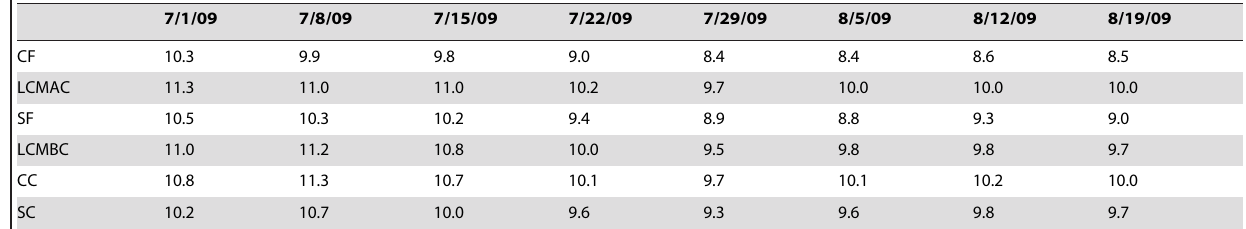
Table 5. Dissolved Oxygen